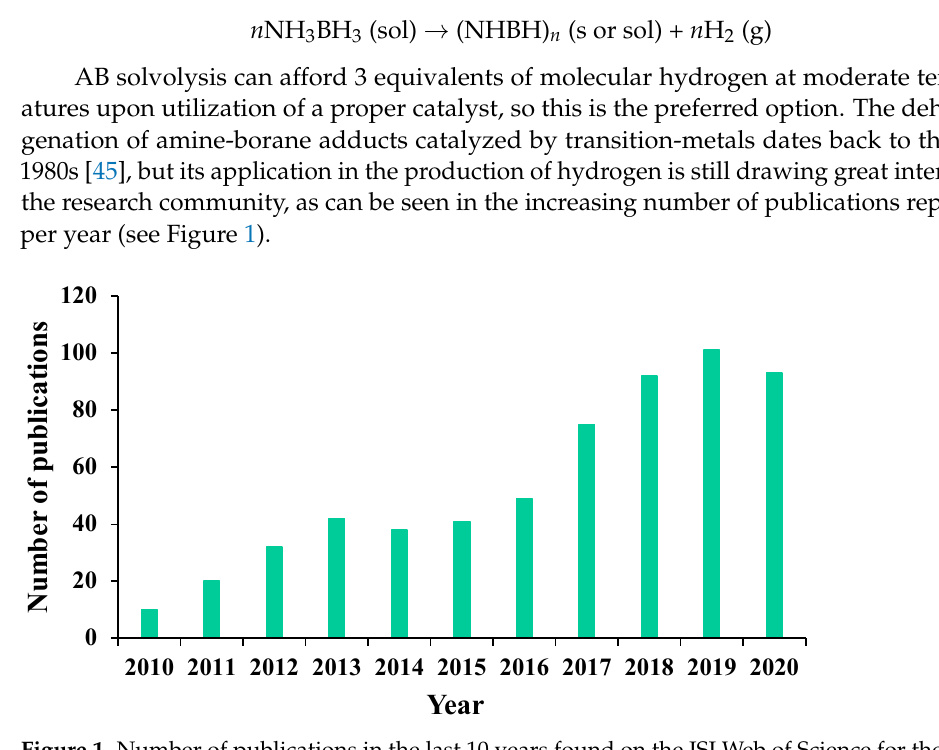
Figure 1. Number of publications in the last 10 years found on the ISI Web of Science for the entry “hydrogen production and ammonia borane”.